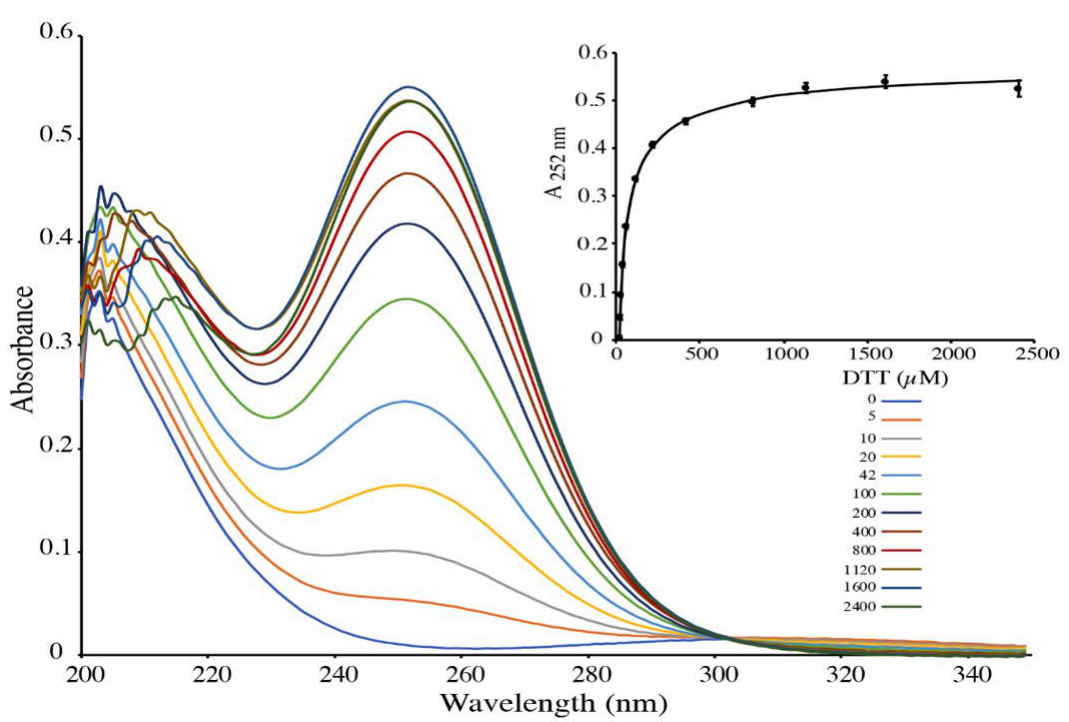
Figure 4. Redox titration of DMDSe with DTT. 50 µ M DMDSe was mixed with increasing concentrations of DTT (0 to 2400 µ M) in 100 mM potassium phosphate, pH 7.4 and UV absorption spectra were recorded. Inset: The absorbance at 252 nm was plotted against DTT concentration and fitted to the theoretical